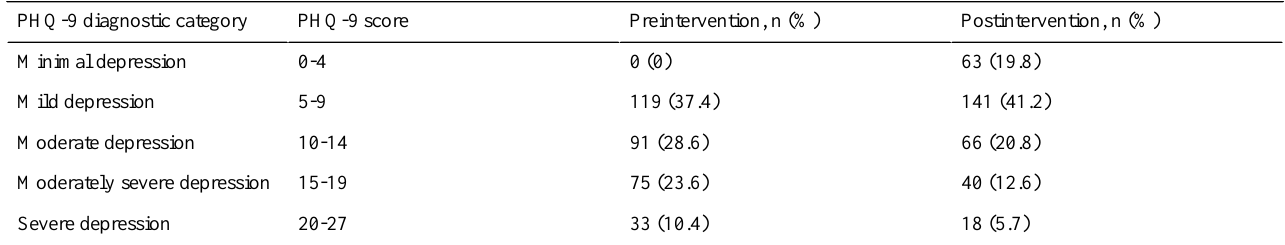
Table 1. Preintervention and postintervention Patient Health Questionnaire (PHQ-9) scores by the diagnostic category